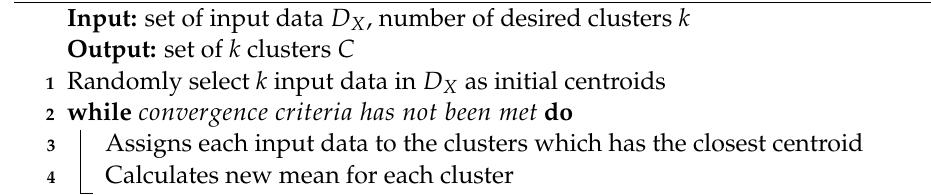
Algorithm 1 Pseudo code of k-means